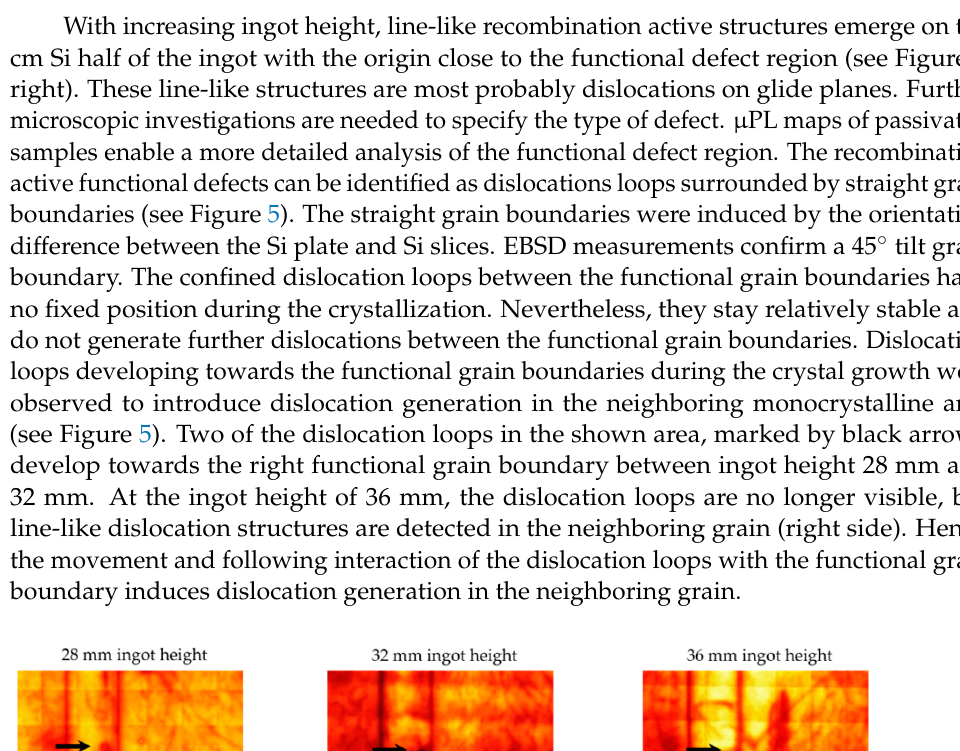
Figure 4. PL image of monocrystalline area surrounded by functional defects on as cut wafers at 28 mm ( left ) and 70 mm ( right ) ingot height.